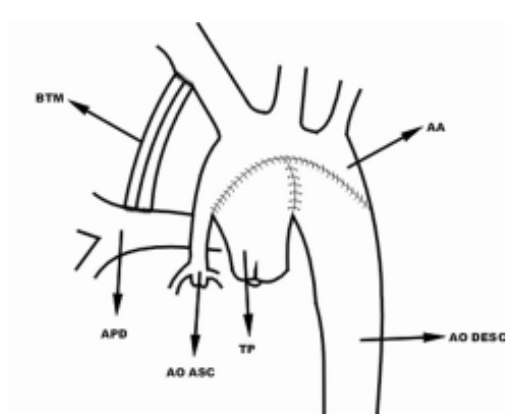
AA: Arco Aórtico; Ao Asc: Aorta Ascendente; Ao Desc: Aorta Descendente; TP: Tronco Pulmonar; AP: Artéria Pulmonar Direita; BTM: Blalock Fig. 1 - Desenho esquemático da técnica cirúrgica empregada .